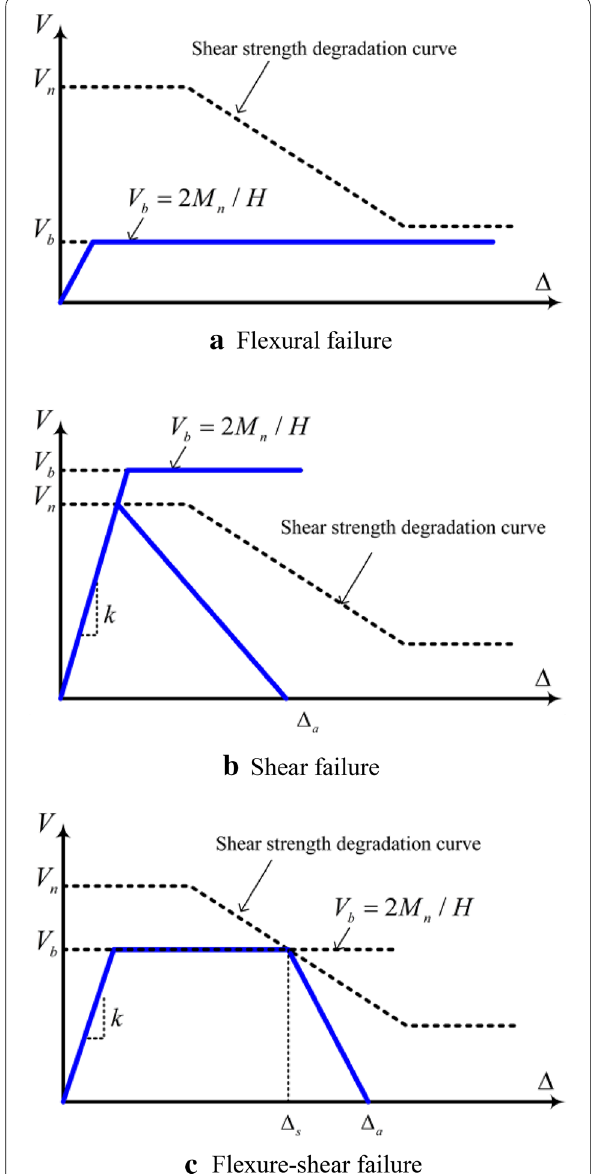
Fig. 18 Lateral load‑deformation relationship of